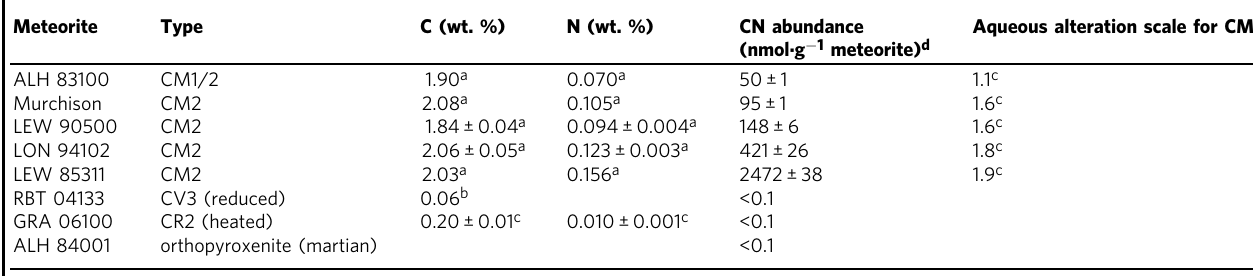
Table 1 Summary of cyanide abundances in meteorites